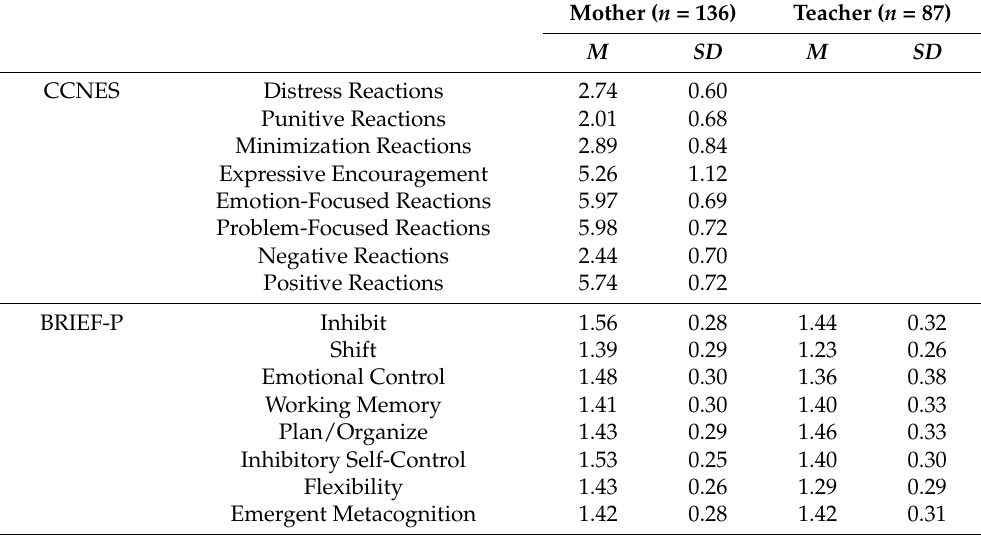
Table 1. Means and standard deviations regarding CCNES and